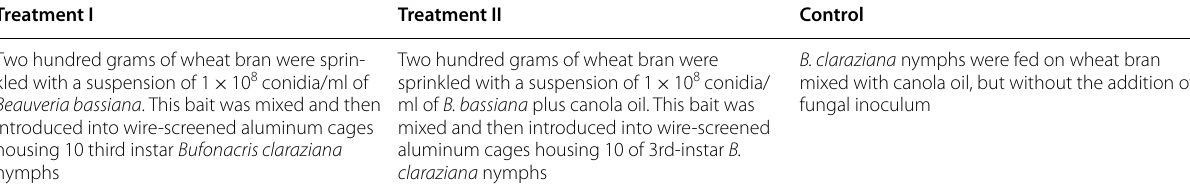
Table 1 Treatments with Beauveria bassiana against nymphs of Bufonacris claraziana carried out under laboratory conditions